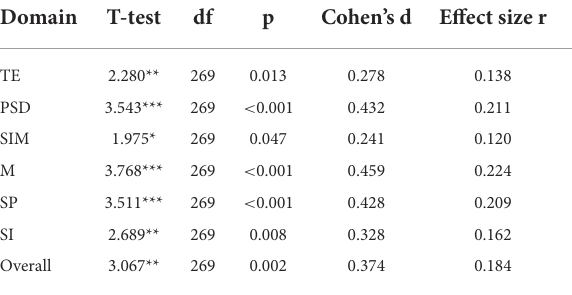
TABLE 5 T-test the effect of COVID-19 on the academic expectations of students (during –post)